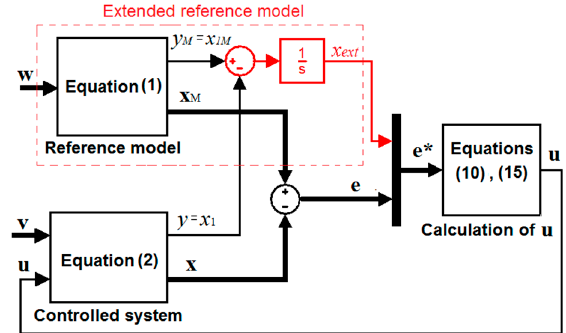
Figure 1. The structure of the designed controlled